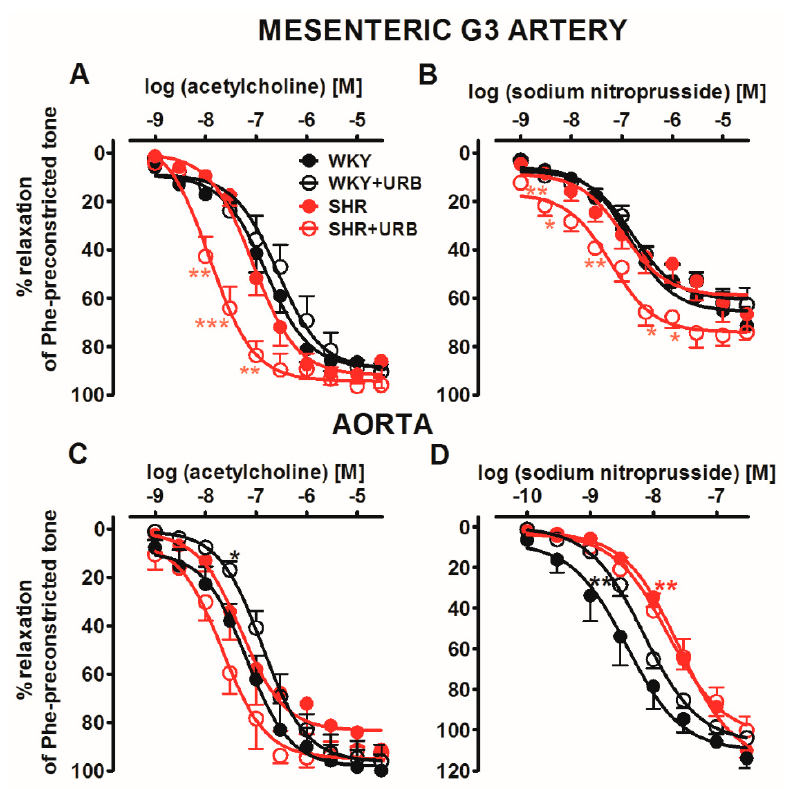
Figure 3. Vasorelaxant effects of acetylcholine ( A , C ) and sodium nitroprusside ( B , D ) in the mesenteric G3 arteries ( A , B ) and aorta ( C , D ) from normotensive control (WKY) and URB597-treated (WKY + URB) rats or hypertensive (SHR) and URB597-treated (SHR + URB) rats. URB597 at 1 mg/kg or its vehicle was injected intraperitoneally every 12 h for 14 days. Vasodilatory responses are shown as percentages of the reference response of the isometric contraction induced by phenylephrine (Phe). Mean ± SEM of n = 6 tissues for each curve. * p < 0.05, ** p < 0.01 and *** p < 0.001 compared to the * WKY, as determined by one-way ANOVA followed by Bonferroni’s multiple comparison tests. In a few cases, the SEM is smaller than or equal to the size of the symbols. See Tables 1 and 2 for statistical